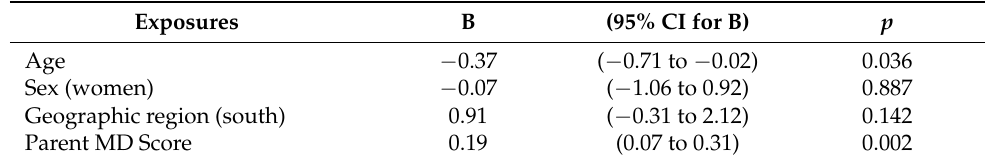
Table 2. Determinants of students’ Mediterranean Diet (MD) score at multivariate linear regression *. Exposures